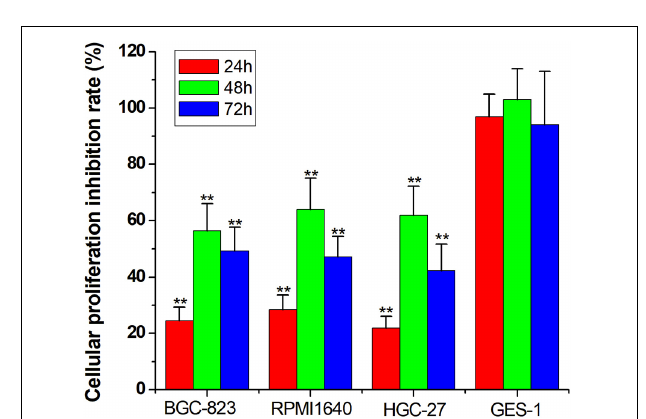
expressed as mean ± SD.